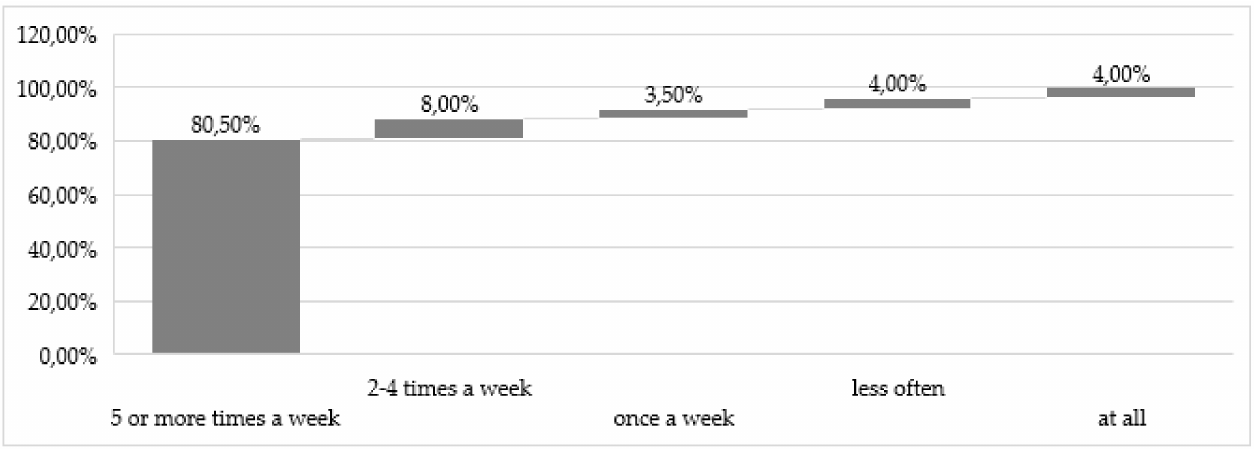
Figure 7. Education.